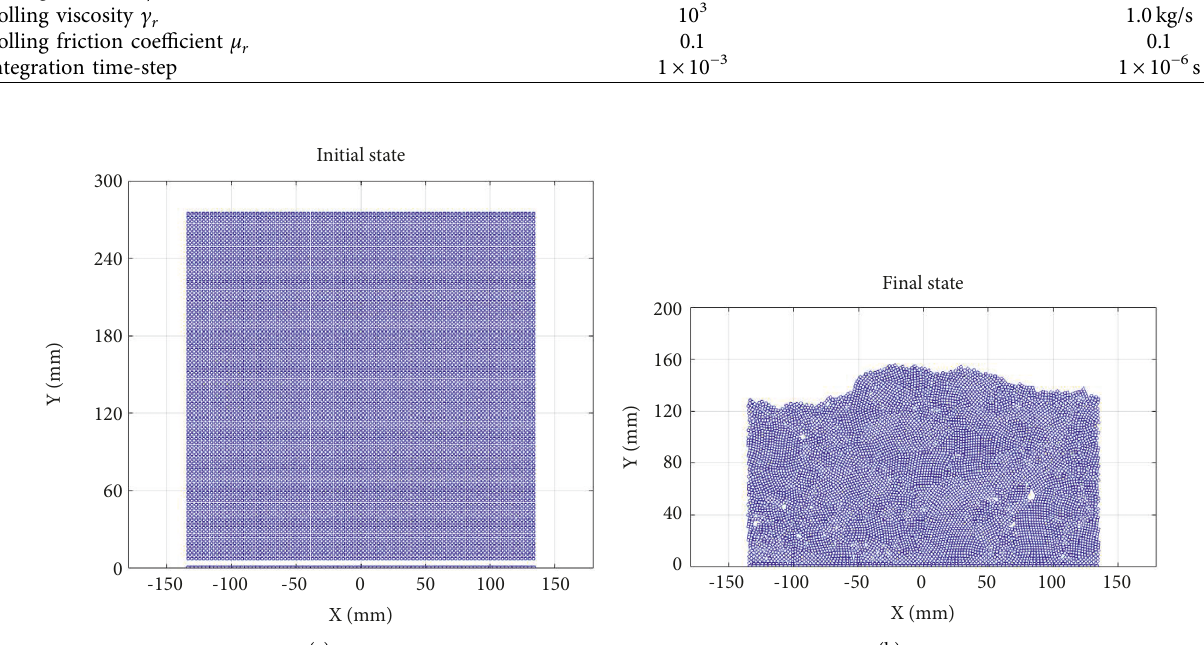
Figure 11: Random packing process of superellipses. (a) Initial state and (b) equilibrium state of the